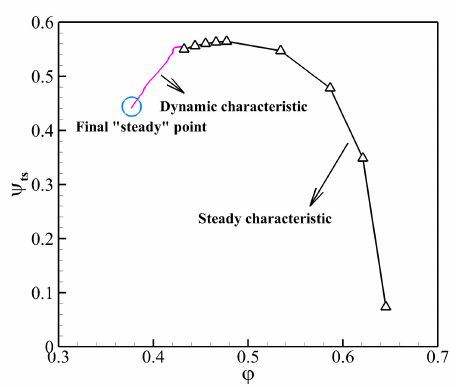
Figure 15. Calculated flow coefficient versus time for the fan.